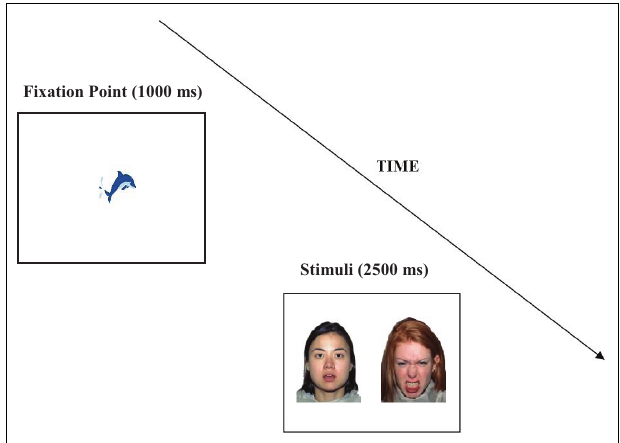
FIGURE 1 | An example of the face stimuli pairs used in the eye-tracking experiment and an illustration of a trial structure